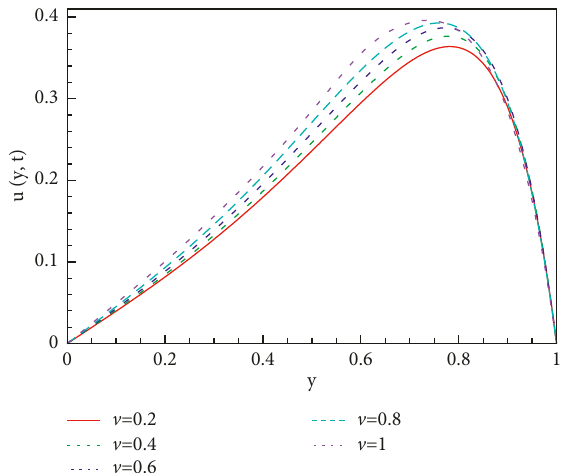
Figure 7: Influence of α � β � ] on u when λ α